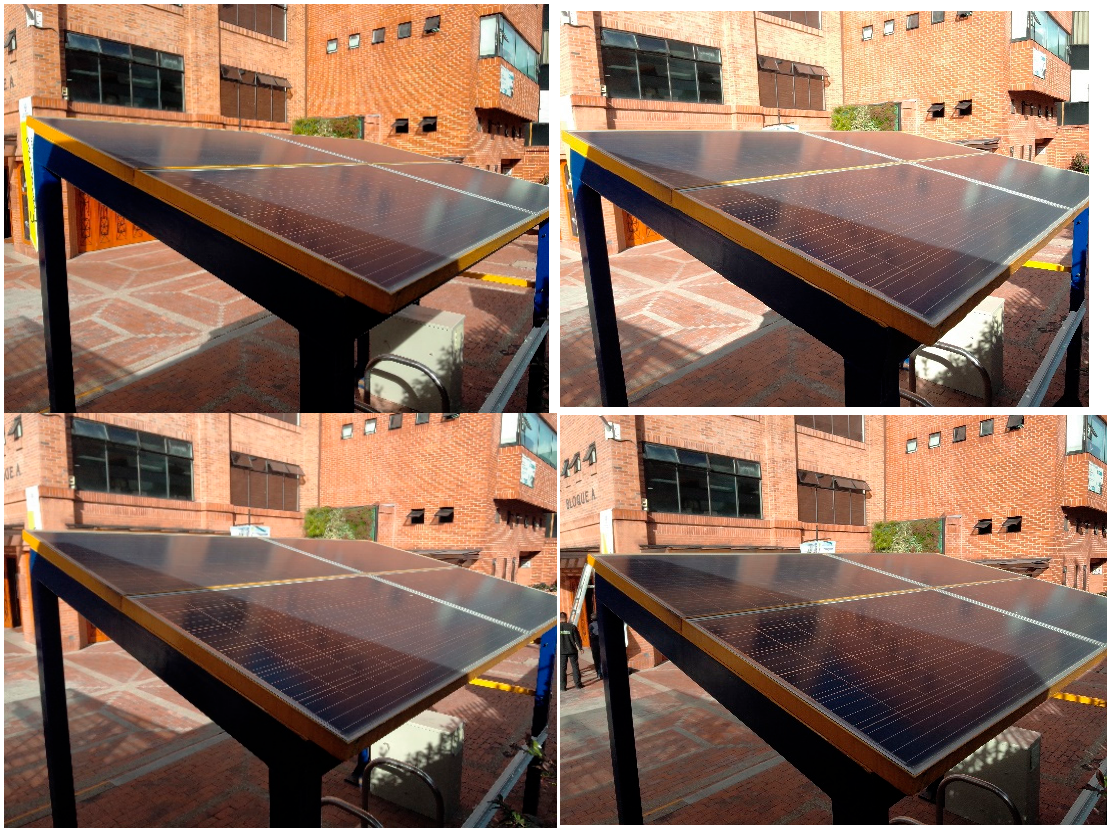
Figure 29. Partial shading phenomenon PSC in BiCiSOLAR charging station.